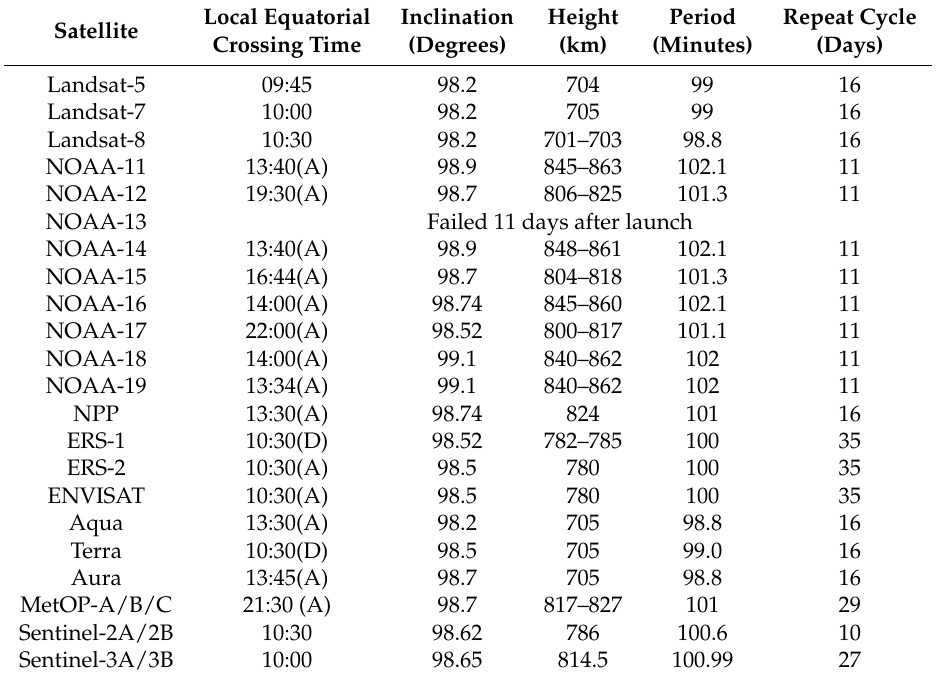
Table 1. Non-exhaustive list of Earth obervation (EO) near polar-orbiting satellites carrying instruments useful for volcano monitoring from the 1970s to present. There are many other satellite platforms but this table contains the most commonly used. A = Ascending node; D = Descending node. See [5] for an encyclopaedic description of satellites and systems for observing the